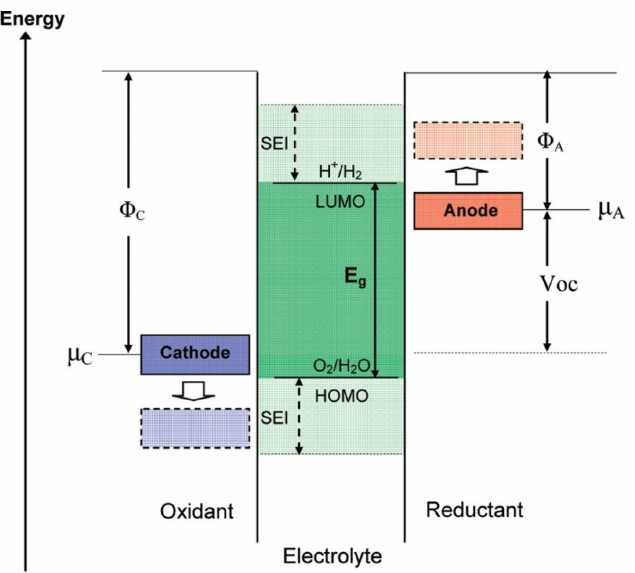
Figure 4. Schematic diagram of open circuit energy in liquid electrolytes. Φ A and Φ C are the anode and cathode working potentials, respectively. E g is the electrolyte thermodynamic stability window. μ A > LUMO and/or μ C < HOMO indicate that the SEI layer needs to be formed to reach a kinetically stable state [2].